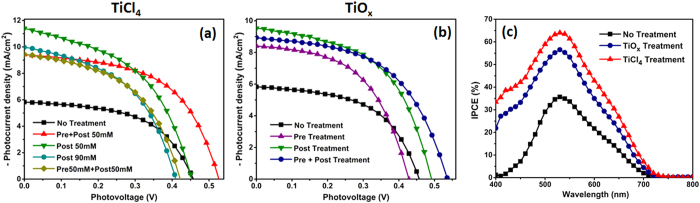
(a) Photocurrent density–photovoltage (J-V) characteristics of SnO2 nanoparticle based DSSCs, under 1 Sun illumination, obtained from pre- and post-treatment of different concentration of TiCl4 precursor; (b) J-V characteristics obtained from pre- and post-treatment of TiOx precursor; (c) Dependence of absolute IPCE of the solar cells with dye-sensitized SnO2 nanoparticle electrodes modified with TiOX and TiCl4 tretament.